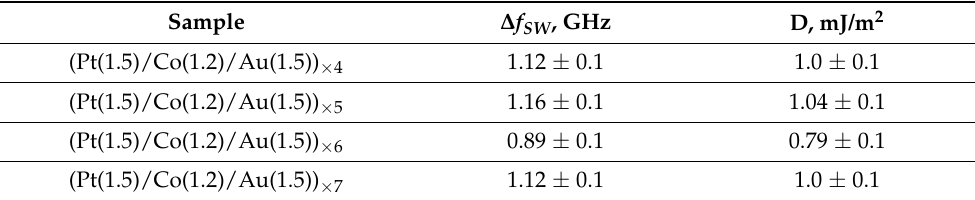
Table 1. The measured value of frequency shift and calculated DMI constant.